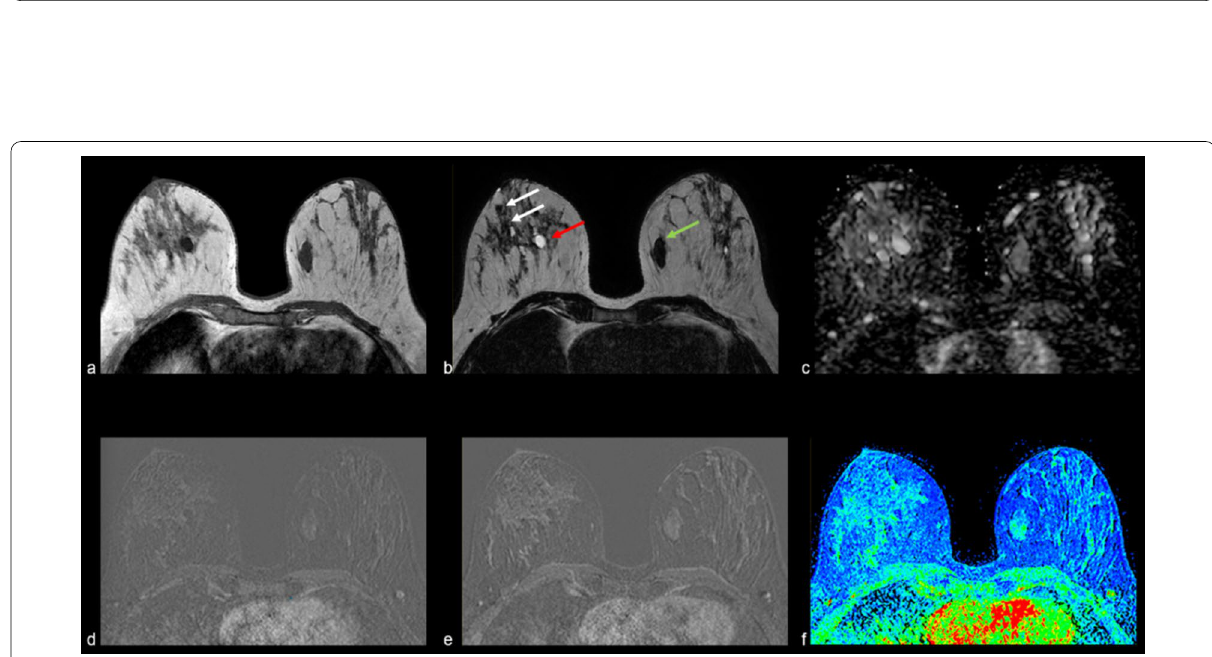
Fig. 4 Example of MRI findings of breast lesions categorized as BIRADS 0 and BIRADS 3 by previous examinations. A 43‑year‑old patient with multiple bilateral findings, most of them simple cysts (white arrows). At the left breast (green arrow), a solid lobulated lesion, hypointense on T1W ( a ) and T2W ( b ) sequences, which shows an ADC ( c ) of 1.43 10 − 3 mm 2 /s, with the contrast medium it shows an homogeneous wash‑in pattern ( f ), × with a slight progressive uptake from the initial ( d ) to delayed ( e ) postcontrast subtractions, corresponding to a benign lesion with characteristics of fibroadenoma. At the right breast (red arrow), a nodule, hypointense on T1W ( a ) and hyperintense on T2W ( b ), which shows no restricted diffusivity and no contrast enhancement. Both lesions were categorized as BIRADS